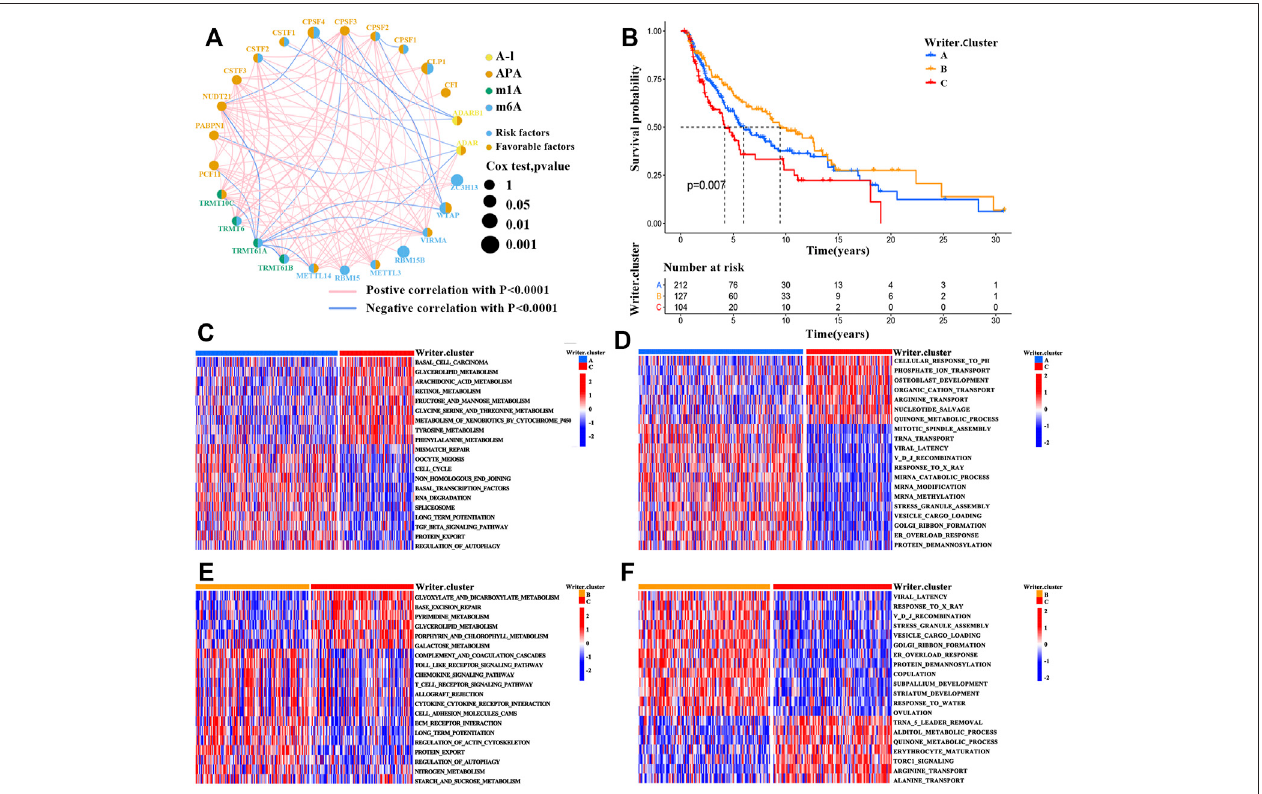
FIGURE 2 | RNA modi fi cation patterns and corresponding biological characteristics of each pattern. (A) The correlations between 26 RNA modi fi cation “ writers ” expression in SKCM. The circle size represented the prognostic value of each regulator. (B) Survival analyses for the three RNA modi fi cation patterns based on 443 patientswithSKCM fromTCGA-SKCMcohort(Log-rank test; p =0.007). (C – F) Comparison ofGSVA and GOenrichmentanalysis(biological pathways) indistinct RNA modi fi cation patterns. (C,E) , GSVA enrichment analysis; (D,F) , GO enrichment analysis; (C,D) , writer cluster A vs. writer cluster B; (E,F) , writer cluster B vs. writer cluster